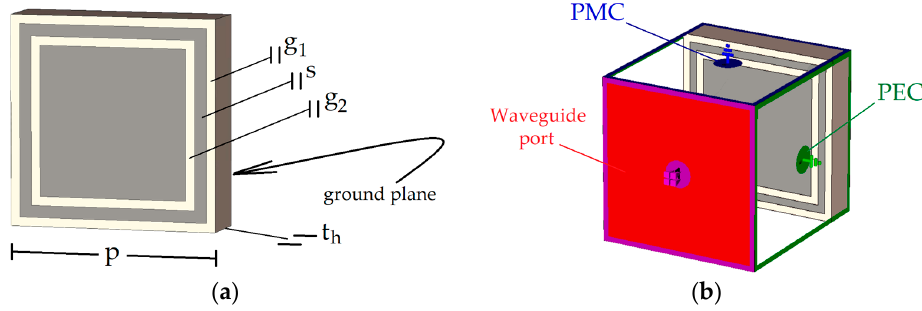
Figure 3. AMC unit cell: ( a ) parameters; ( b ) port and boundary conditions.